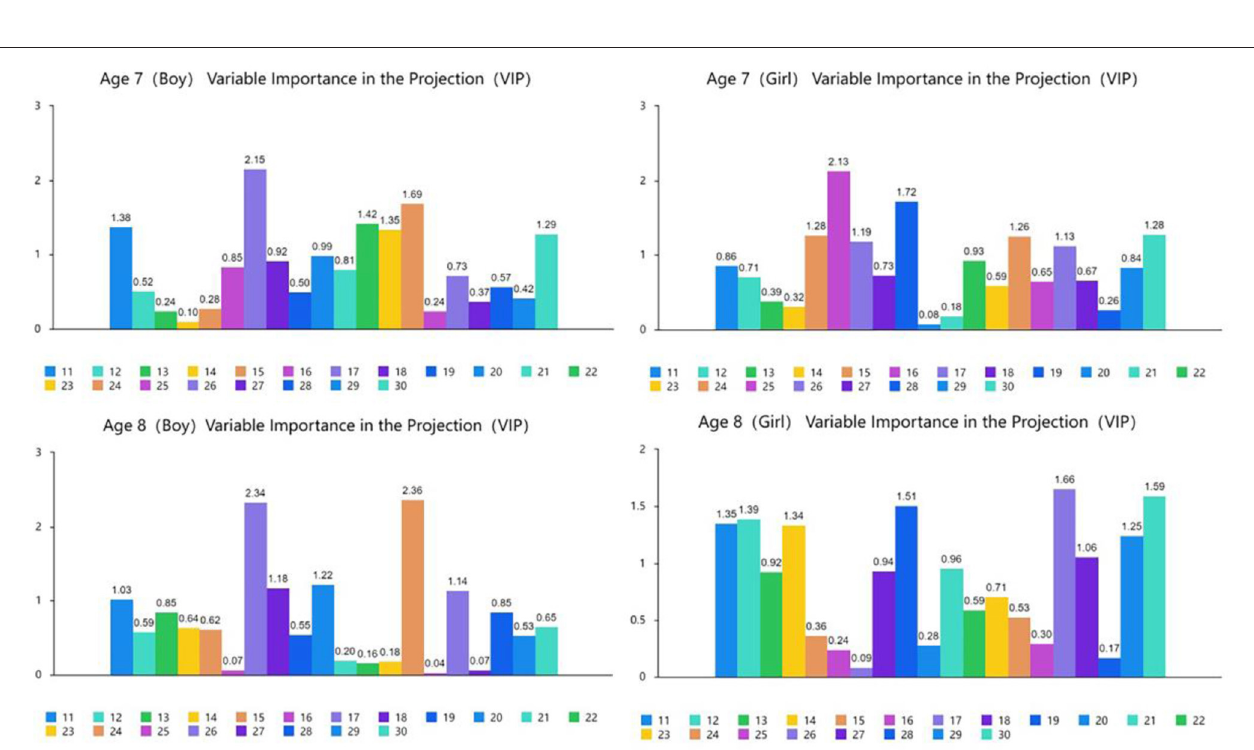
FIGURE 5 | VIP chart of the projection importance index of motor behavior to motor performance.